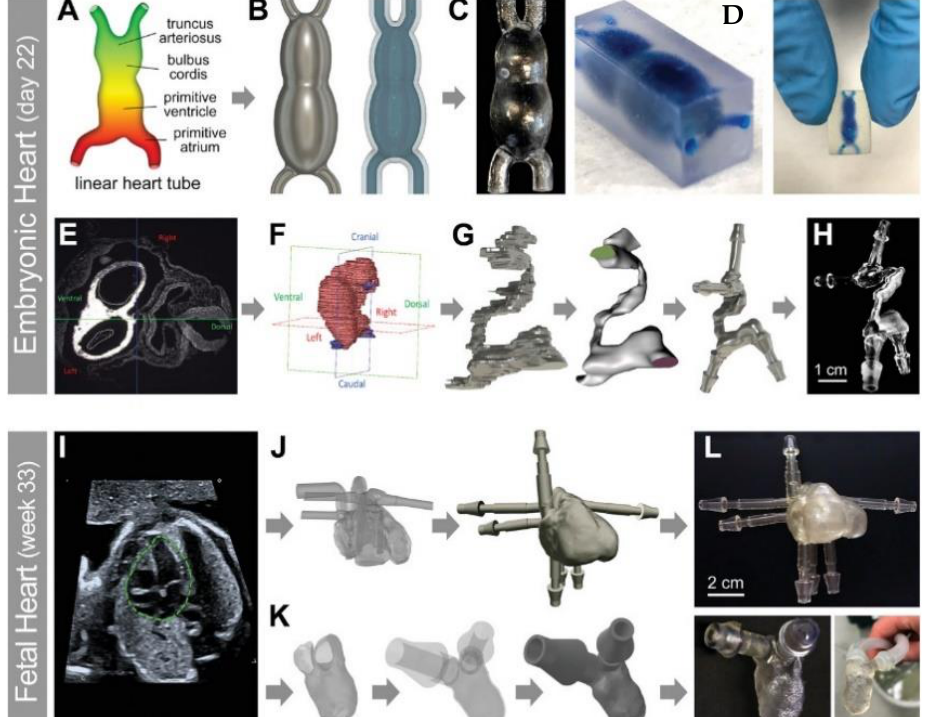
Figure 1. “Experimental workflow used to create patient-derived 3D printed heart models at varying developmental stages. A 3D model of an embryonic human heart at Carnegie stage 10 (21–23 days old, e-HT) was made either through ( A – D ) CAD modeling of an idealized structure, or ( E – H ) using the actual human data obtained in collaboration with the 3D Atlas of Human Embryology. The anatomical heart tube model contained the ( E ) primitive cardiovascular system which was ( F – H ) trimmed to only include the linear heart structure. ( I – L ) A patient-specific fetal left ventricle (f-LV) was acquired from fetal echocardiography of the human heart (week 33). The ( I ) full heart model was ( J – L ) trimmed at the mitral and aortic valves to only include the inner surface of the LV. For both models, the geometries were optimized, hollowed, and smoothed using the Meshmixer. Flow extensions were appended using AutoDesk Fusion 360 at the trimmed inlets and outlets to simulate adjacent vasculature. Different scales of ( C , H ) e-HT and ( L ) f-LV constructs were 3D printed by a Form 2 printer using the clear resin. ”— [ A. D. Cetnar et al., “Patient -Specific 3D Bioprinted Models of Developing Human Heart,” Adv. Healthc. Mater., vol. n/a, no. n/a, p. 2001169. Reproduced with permission.].